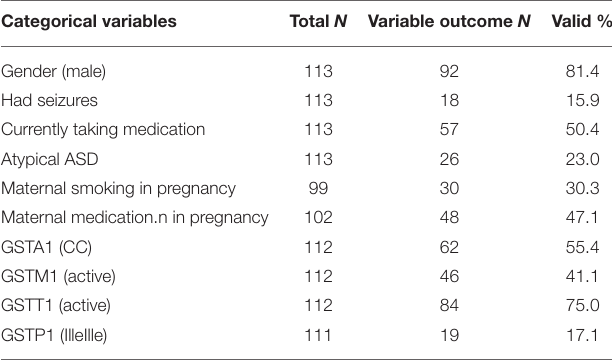
TABLE 2 | Descriptive parameters of categorical